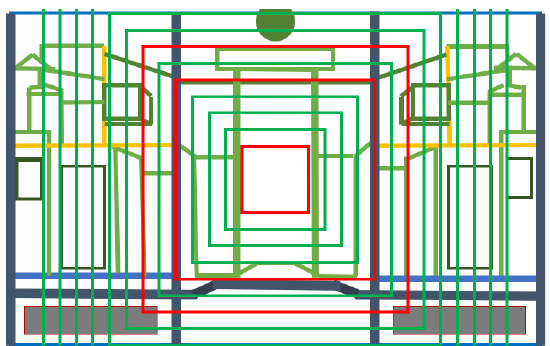
Figure 19. Nested squares instead of circles. Source: the author.